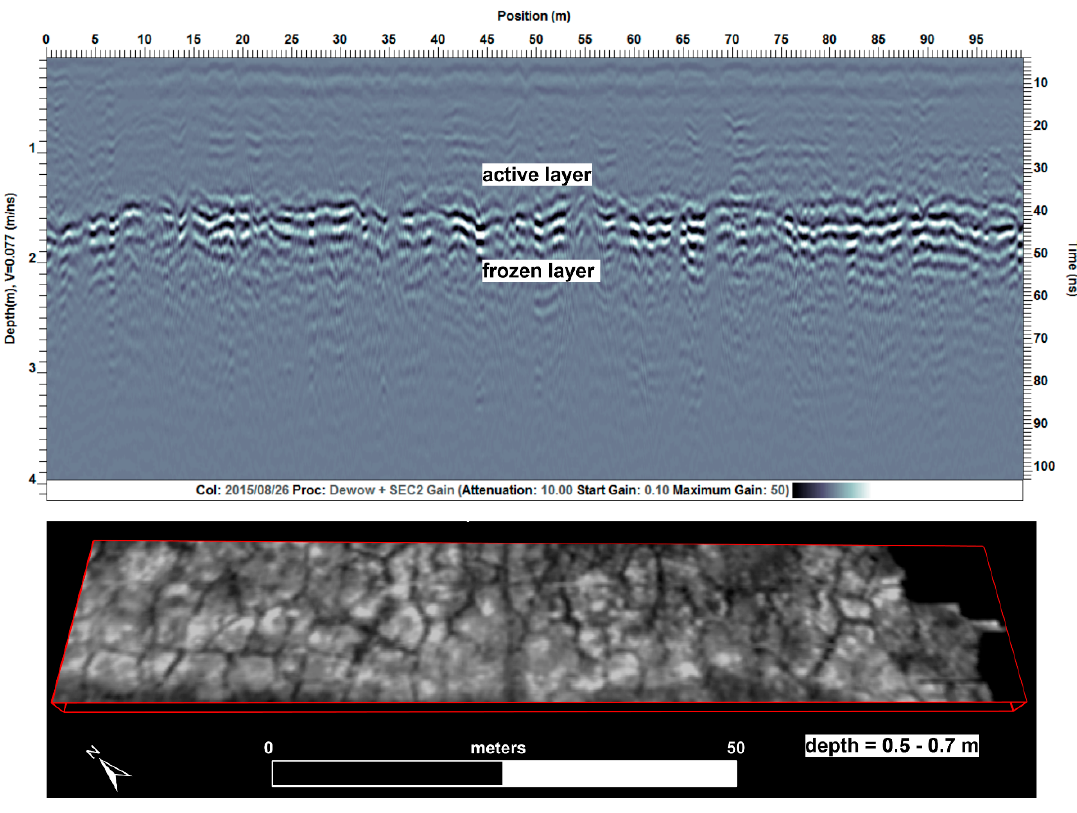
Figure 5. The late summer (August) permafrost table at the Old Whaling Ridge. This is the full extent of the same monitoring station shown in Figure 5. A three-trace running average has been applied to emphasize horizontal reflectors. Note that the active layer extends nearly 1 m deeper than the mid-summer depth shown in Figure 5. The active layer exhibits a network of cracks from the freeze-thaw cycle, which are clear in plan-view GPR data ( bottom ). In isolation, perimeters of these frost polygons can easily be mistaken for cultural features in the sub-surface.